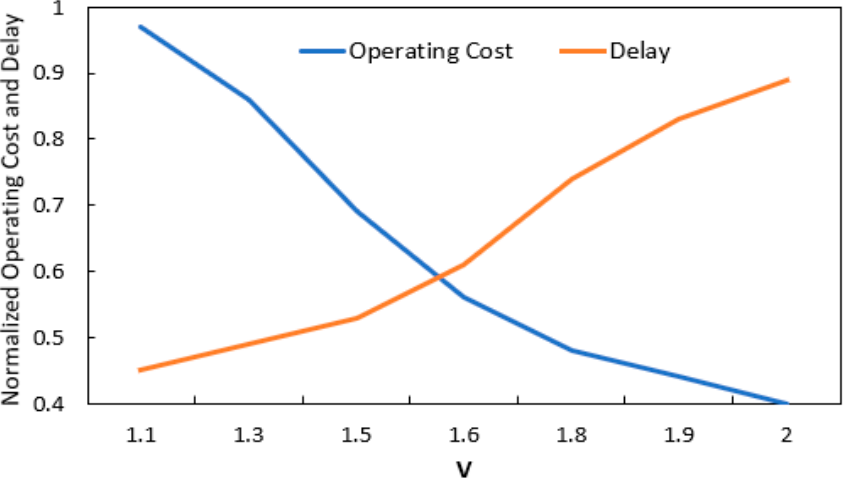
Figure 6. Operating cost and delay performance of RLB-Option with different values of 𝑉 .